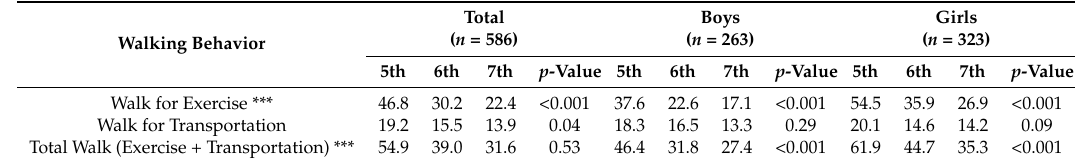
Table 2. Walking behaviors (% Yes) in the past five days by gender and grade-level among participants in the TRACK study ( n = 586).